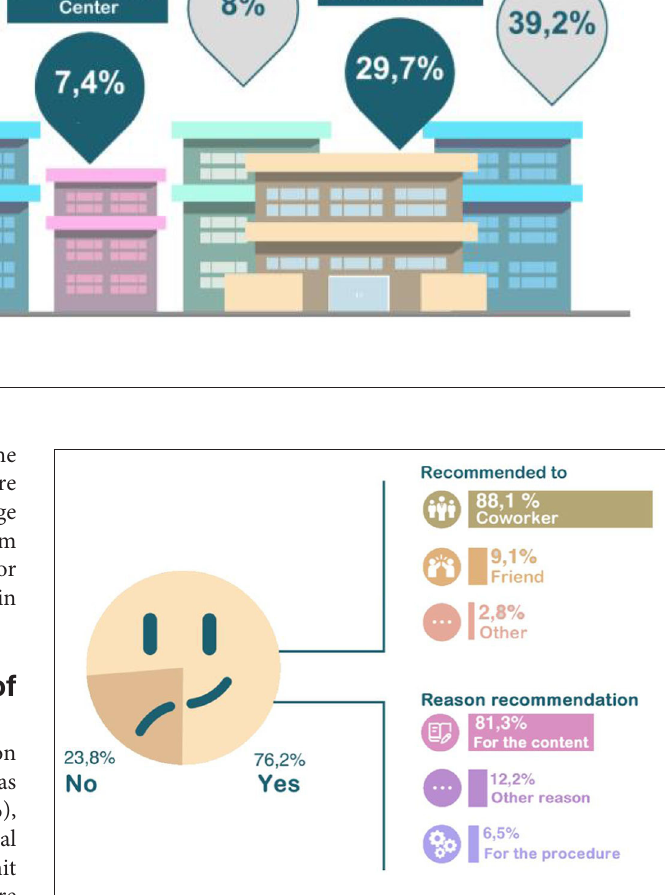
FIGURE 7 | Reason for taking courses at